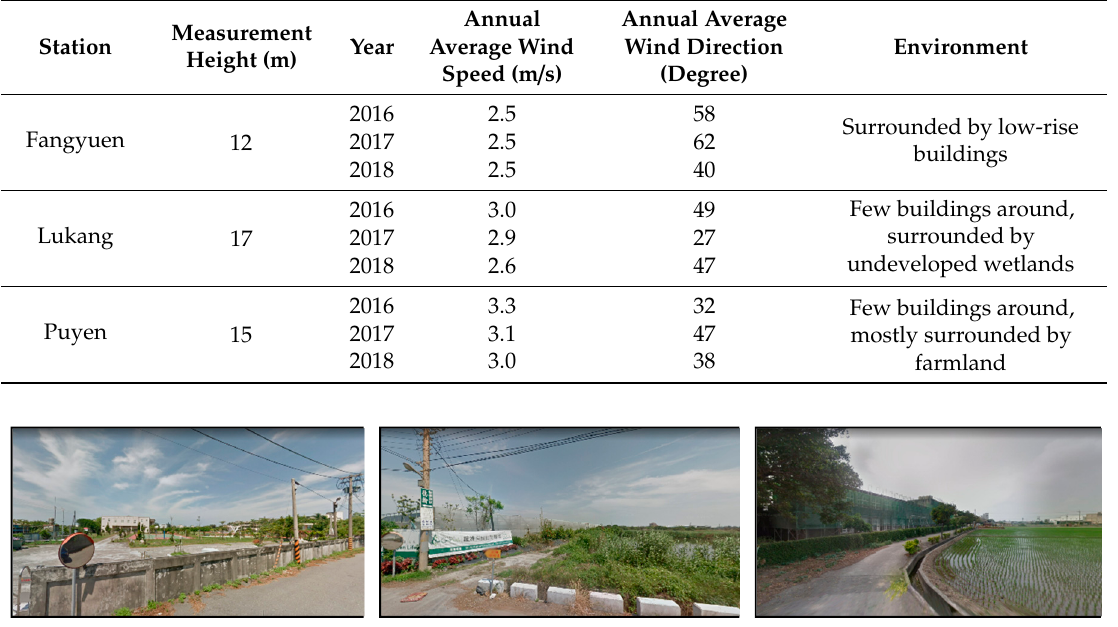
Table 6. Information and wind measurement data of CWB stations [34].